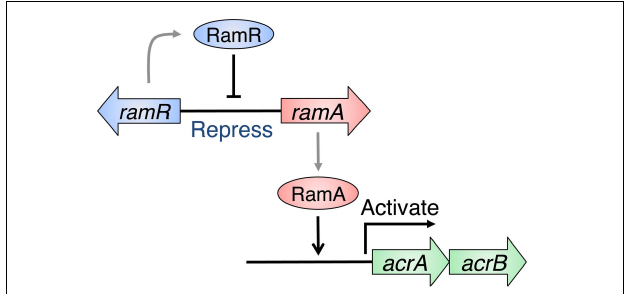
FIGURE 6 | Regulation of acrAB multidrug efflux genes by RamRA in Salmonella . The expression of the multidrug efflux system genes acrAB is controlled by RamA, an activator protein, and RamR, a repressor. The RamR protein represses the ramA gene expression, which codes for the RamA protein, an expression activator in the acrAB drug efflux system genetic operon. The RamR protein recognizes a specific DNA sequence that exists upstream of the ramA gene and binds to it, repressing its expression.